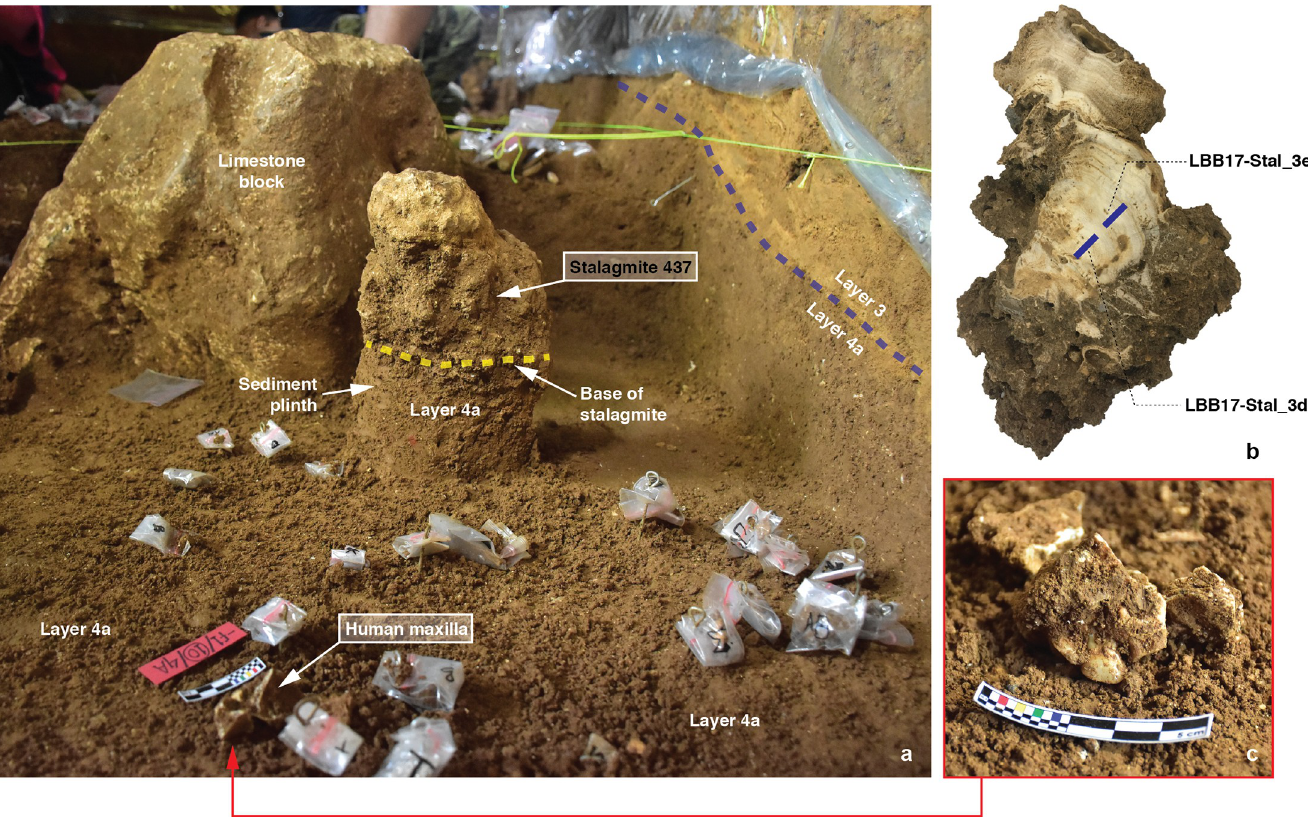
Fig 5. Stalagmite dated using U-series analysis at Leang Bulu Bettue. (a) Stalagmite 437 in situ within the trench under excavation–during the excavation the stalagmite was left in situ on a plinth of unexcavated Layer 4a sediments. The blue dashed line shows the boundary between Layer 4a and overlying Layer 3; (b) cross- section of Stalagmite 437 showing the locations of U-series sub-samples LBB17-Stal_3d and LBB17-Stal_3e, which were used to determine the growth age of the speleothem; (c) human maxilla fragments (Maros-LBB-1a) in situ in Layer 4a below the base of Stalagmite 437.